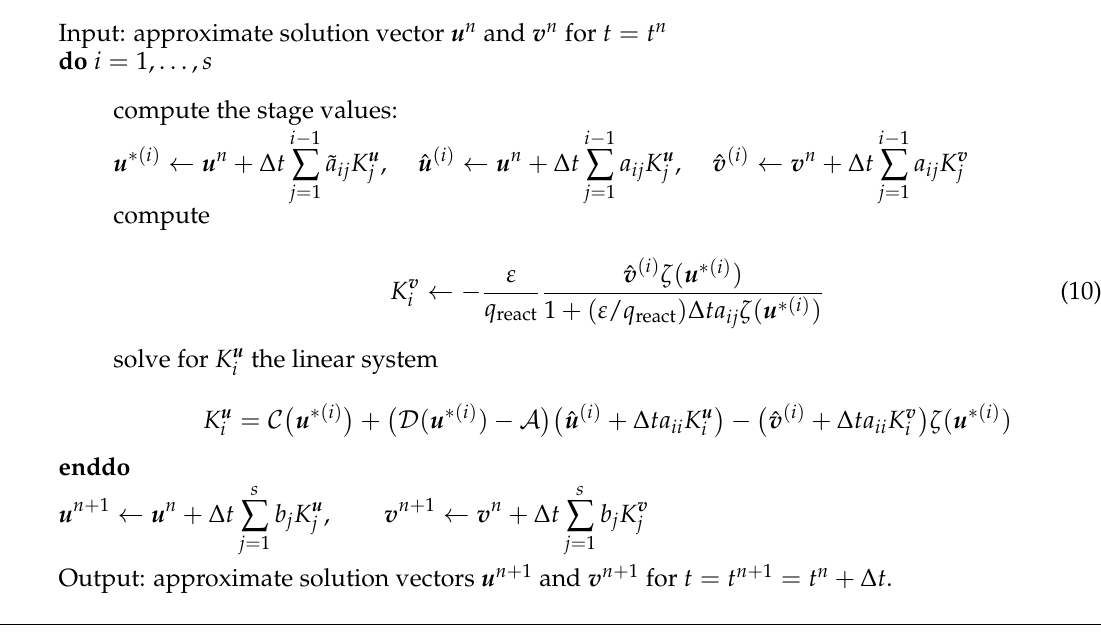
Algorithm 1 LI-IMEX Runge–Kutta